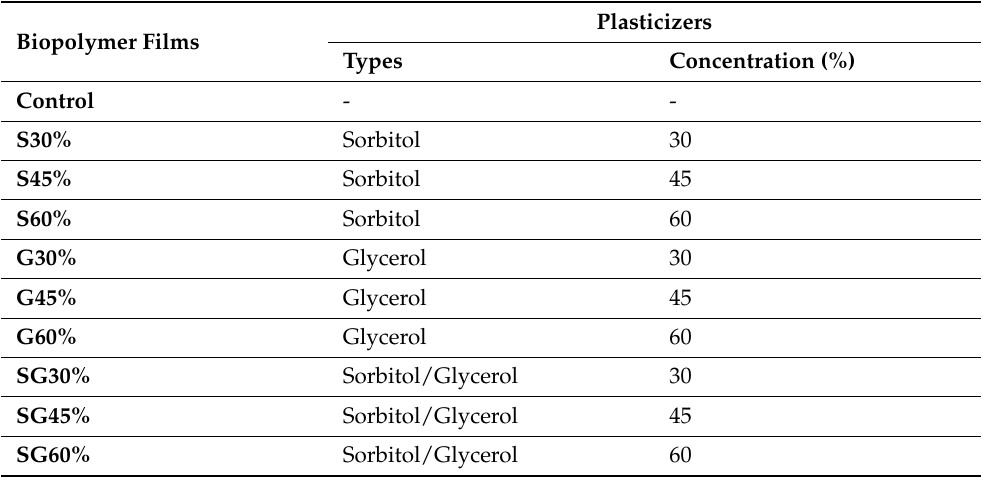
Table 1. Various plasticizer types and concentrations used in cornstarch-based